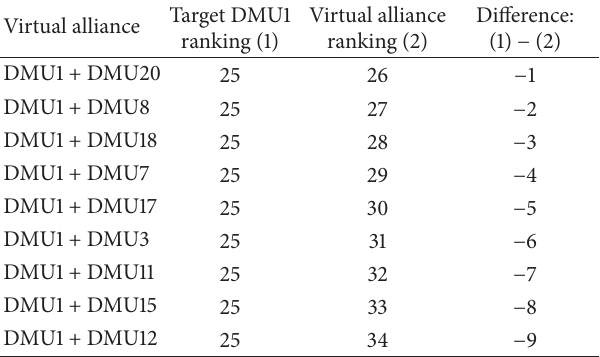
Table 14: The unqualified alliance partnership.